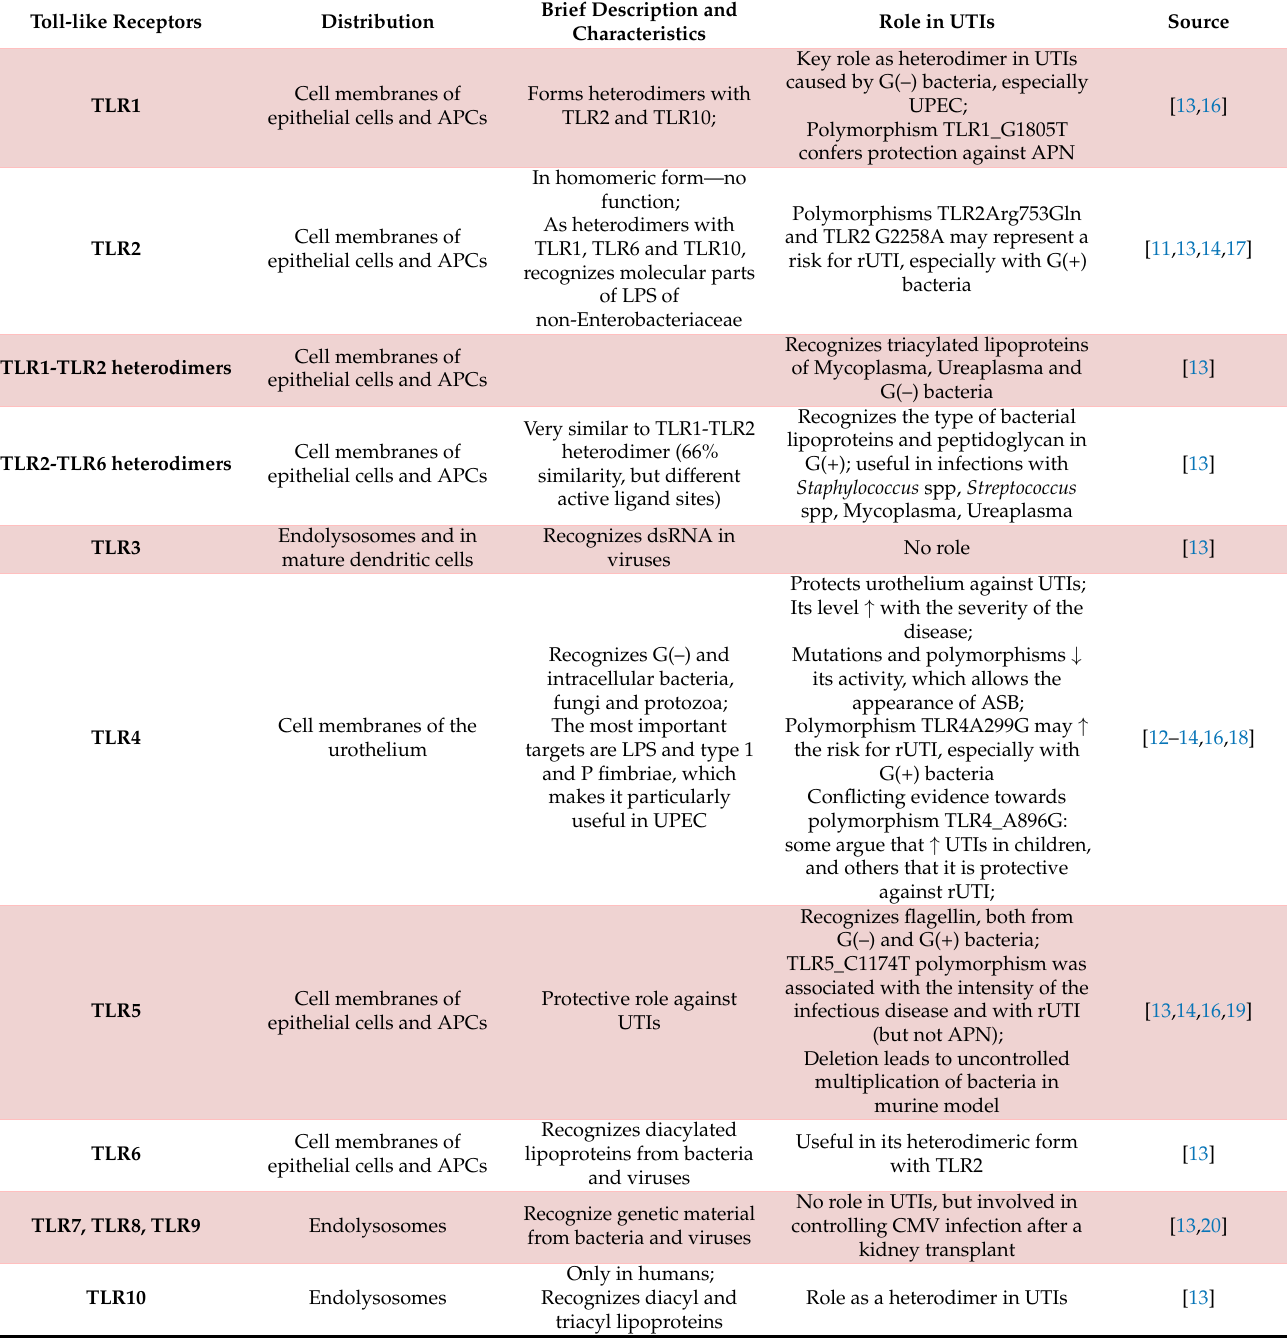
Table 1. The distribution and roles of the toll-like receptors in